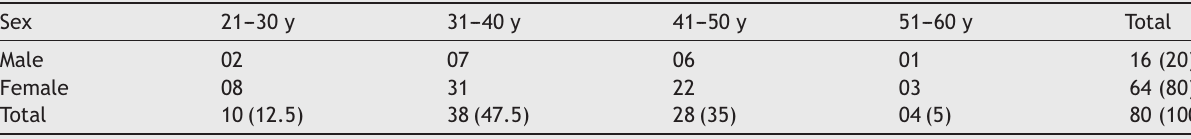
Age and sex distribution of thyroid nodules of 80 cases.